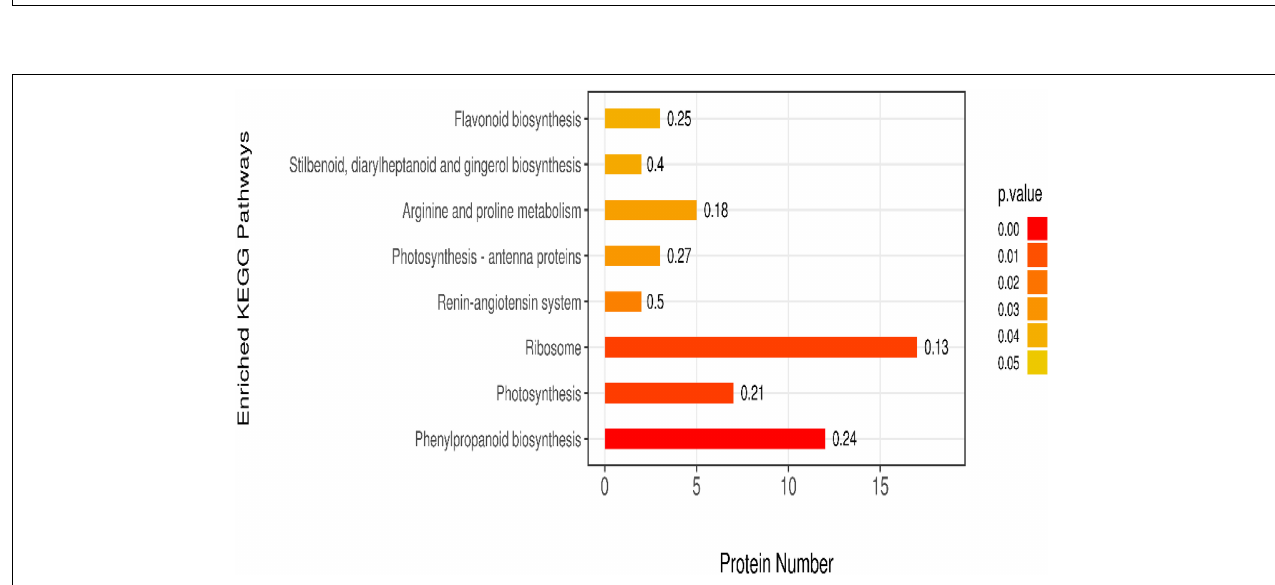
FIGURE 6 | Top 20 enriched GO terms and functional classification of differential proteins.